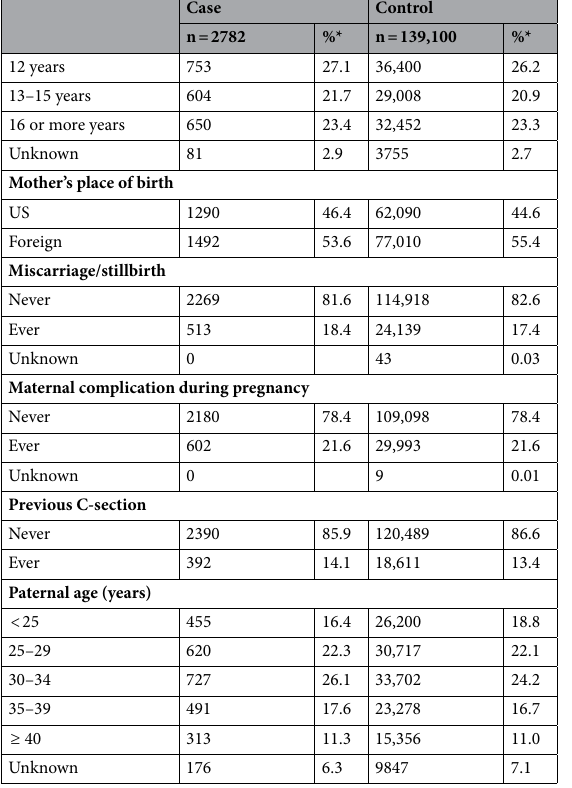
Table 1. Distribution of outdoor artificial light at night, air pollution, and birth characteristics in the California Linkage Study of Early-Onset Cancers. * Percentages may not add up to 100 due to